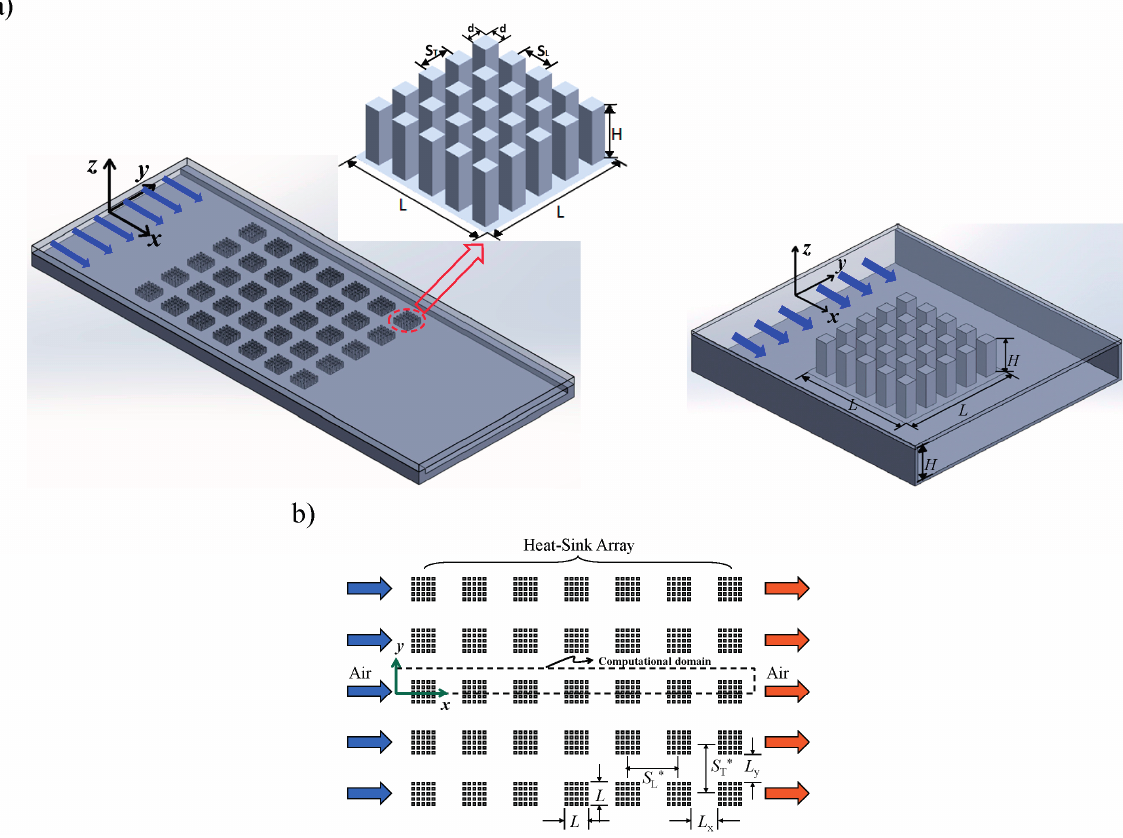
Figure 2. Physical configuration: ( a ) 3D configurations (left: present study; right: previous study [18]); and ( b ) 2D configuration ( x – y plane) cut from the middle of